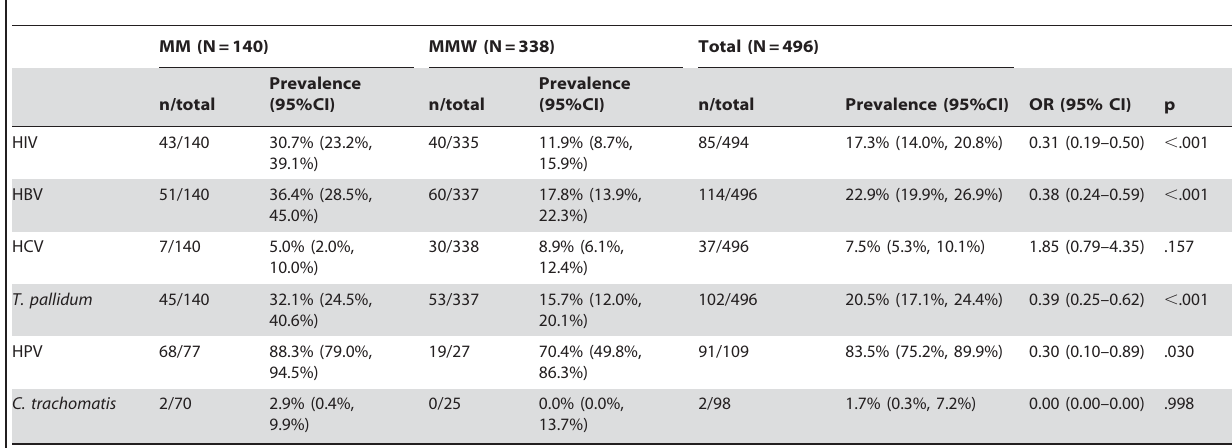
Table 1. STIs prevalence according to type of partner among 496 MSM recruited through RDS in Buenos Aires, 2007–2009.